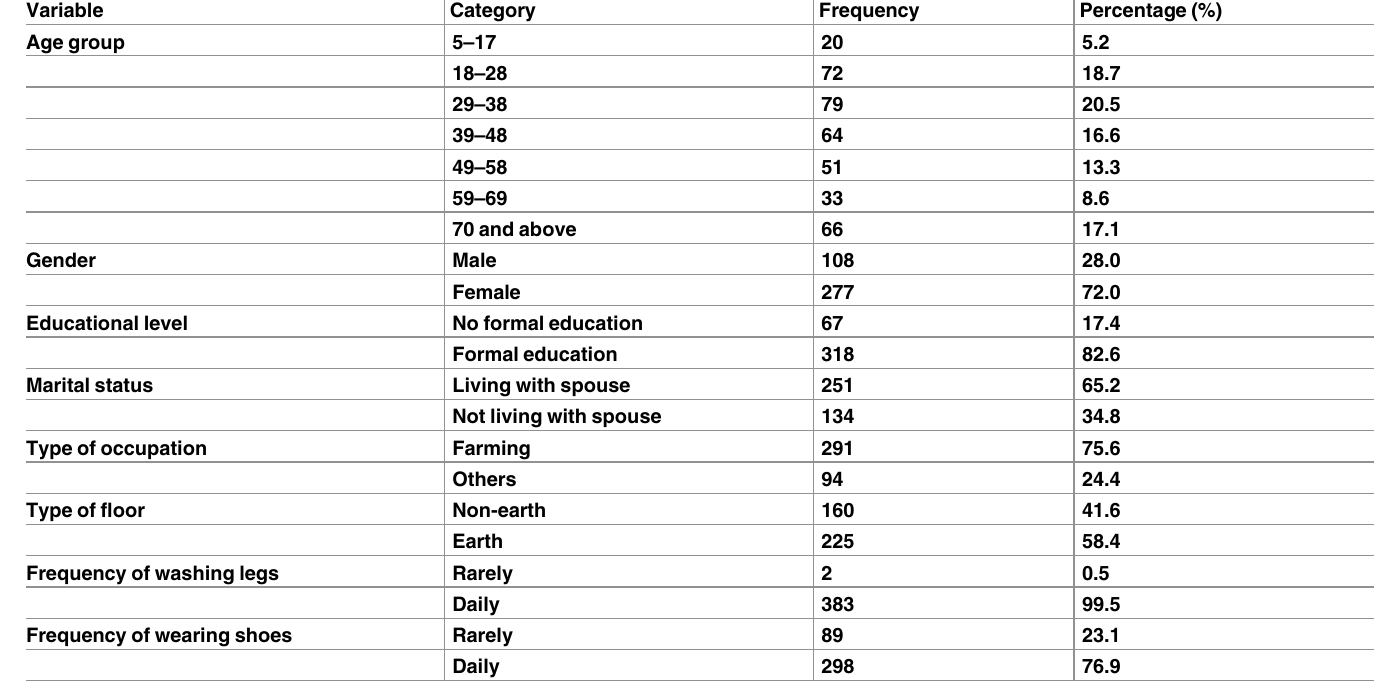
Table 3. Social demographic characteristics of participants (n =